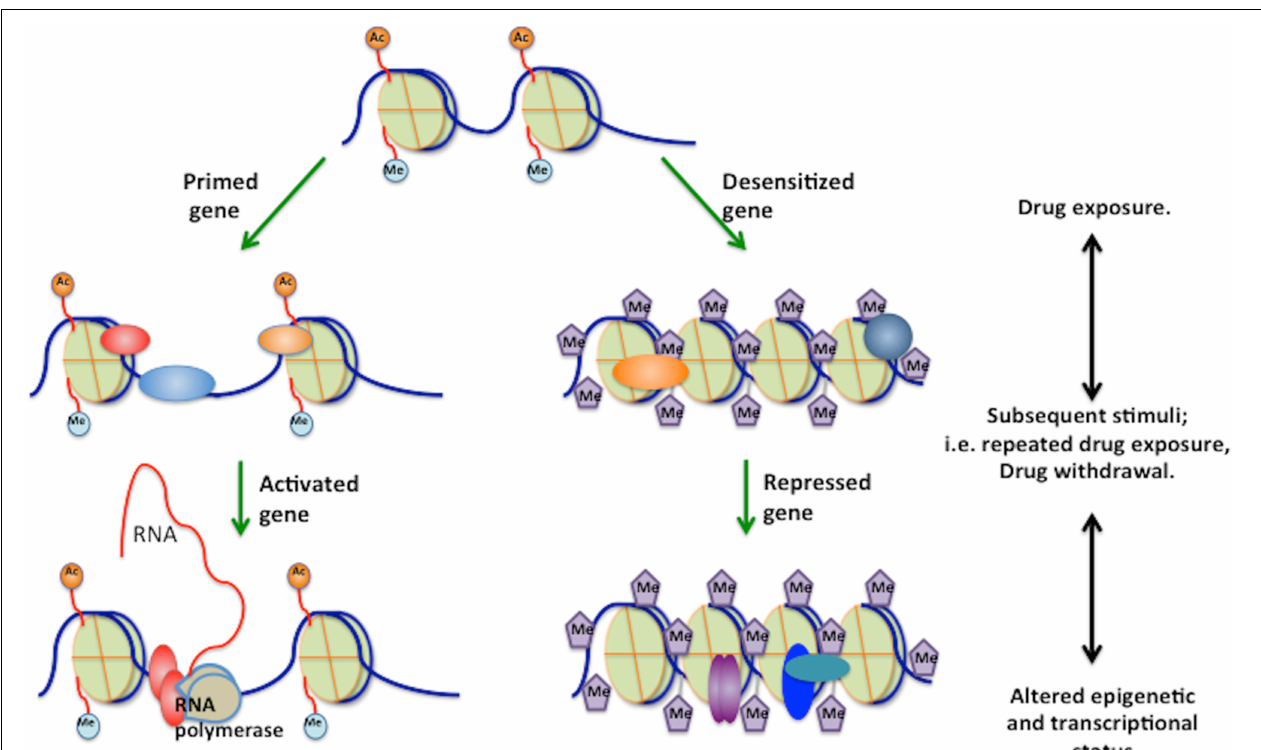
FIGURE 4 | Gene priming. Epigenetic mechanisms mediate gene priming and desensitization under the influence of drugs of abuse, and that many of these changes are latent, meaning that they are not reflected by stable changes in steady-state mRNA levels. Instead, these changes would induce subsequent changes in chromatin